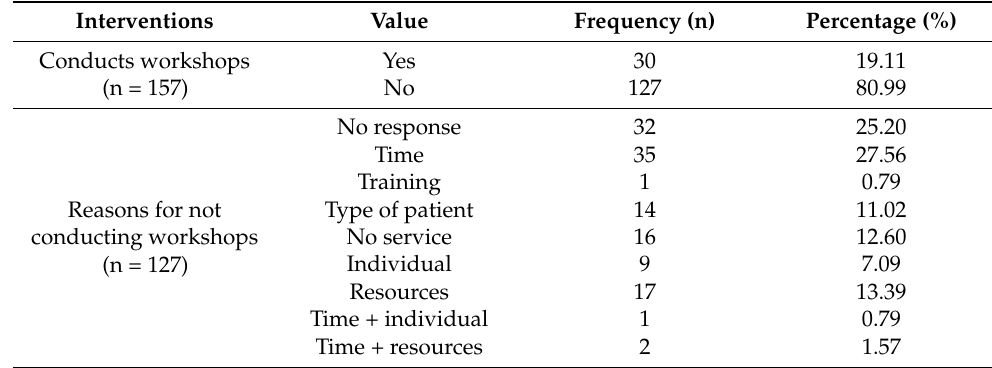
Table 5. Conducting workshops. (n = 127).